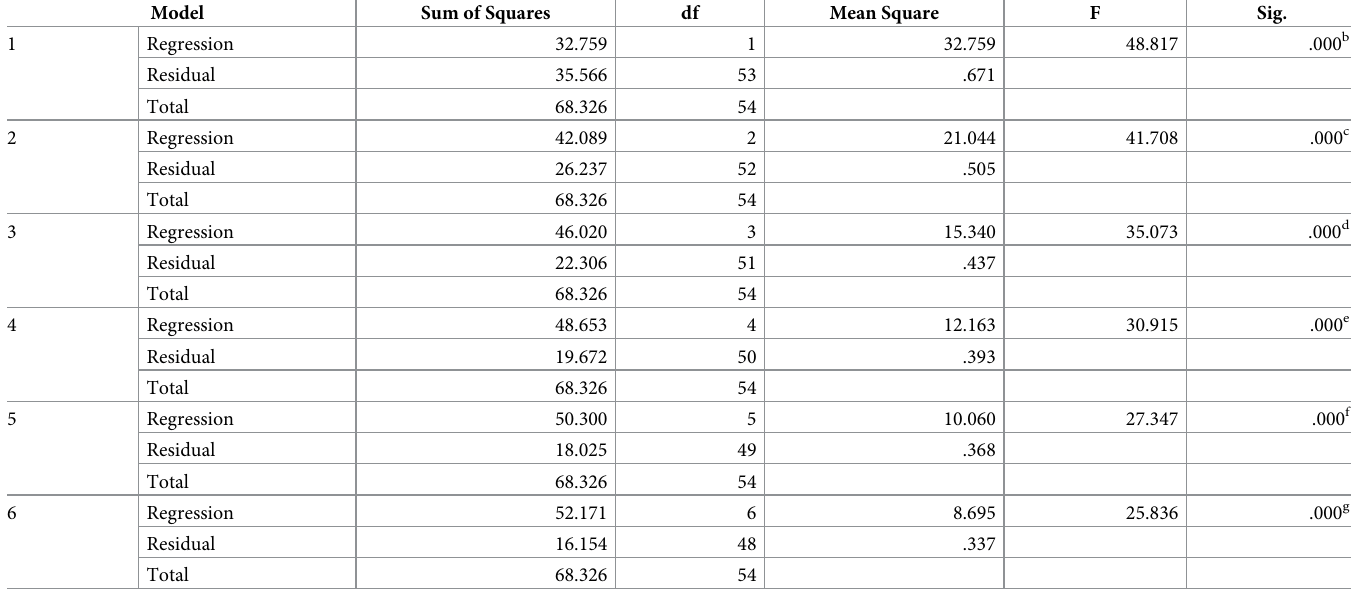
Table 5. ANOVA a test of the linear regression